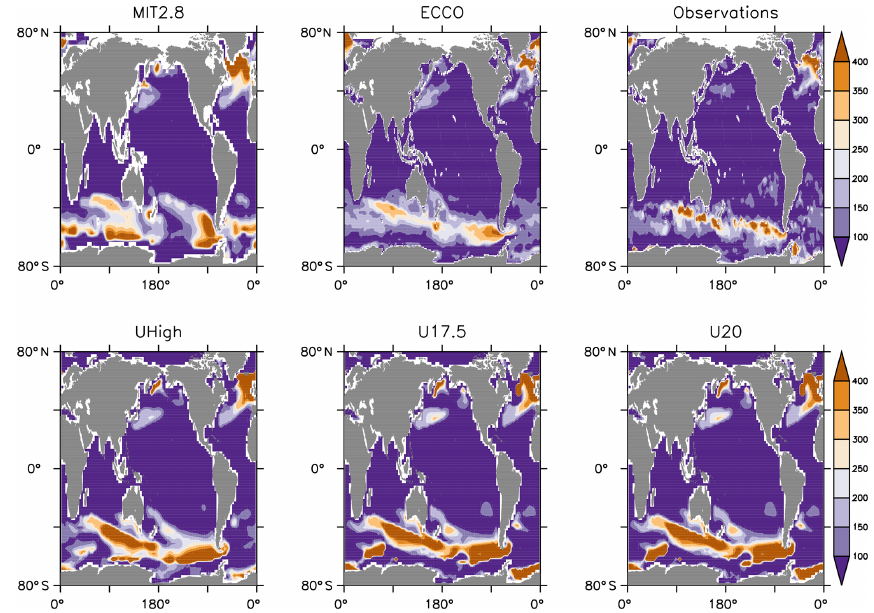
Figure 2. Annual maximum mixed-layer depths of models and observations (gridded onto ECCO model geometry). Mixed-layer depths have been determined from a density difference of σ θ = 0 . 03 (density calculated from monthly mean temperature and salinity).